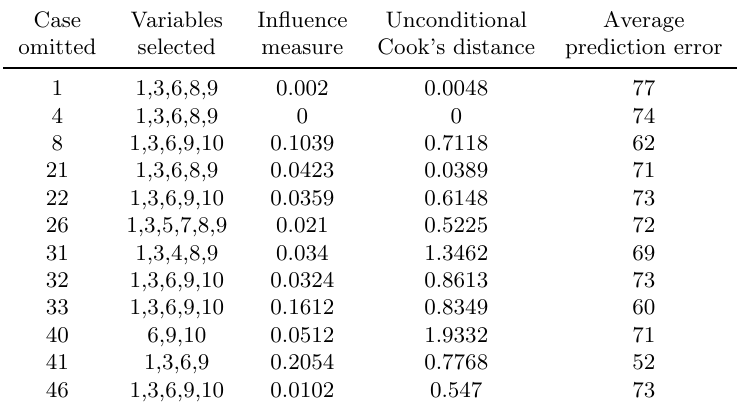
Table 3: Evaporation data: Variable selection with Mallows’ C